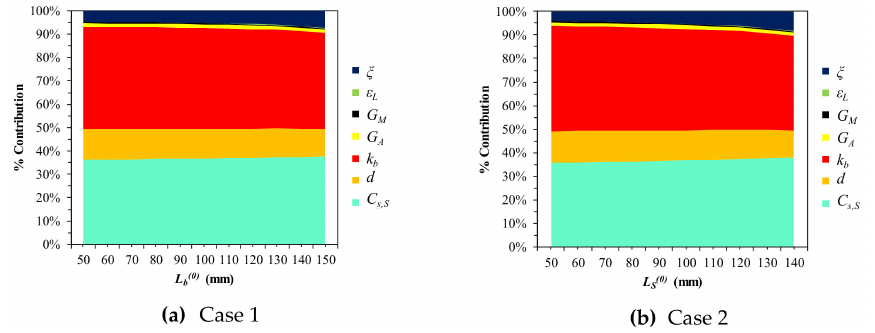
Figure 11. Parametric percentage contribution to SMA spring elongation ( δ S ): ( a ) Variation in bias ( 0 ) = 100); ( b ) Variation in initial SMA spring length ( L = 300, L spring length ( L = 300, L S